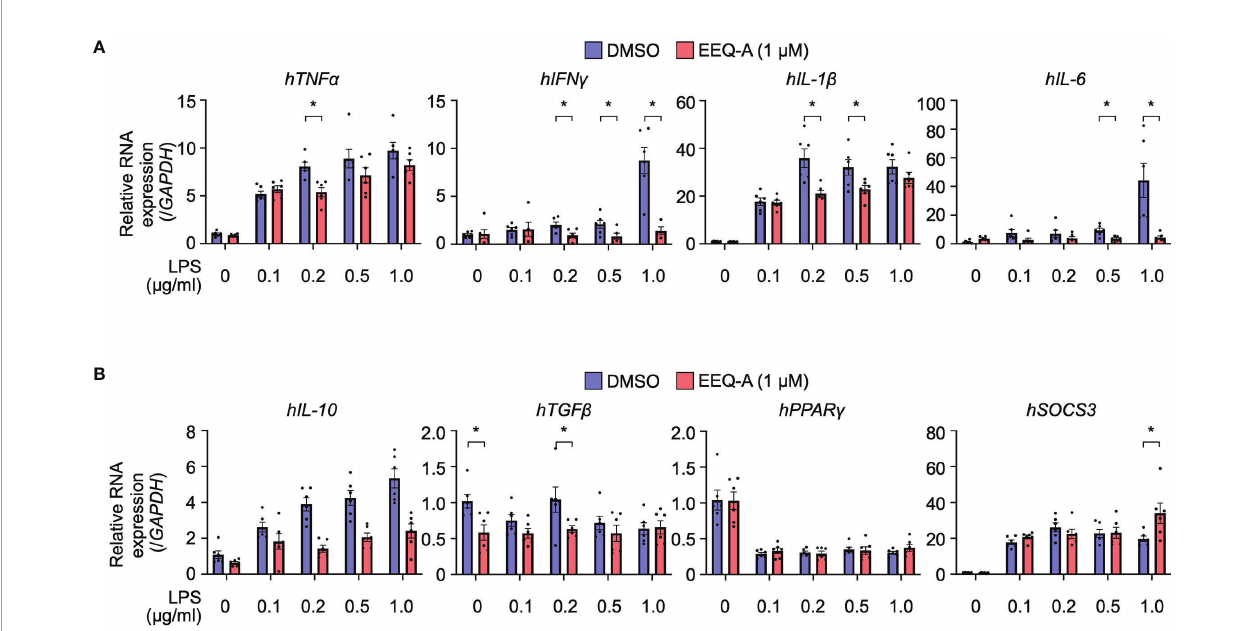
FIGURE 3 | RNA expression of proin fl ammatory (A) and anti-in fl ammatory (B) cytokines in THP-1 cells, the in fl ammation model. The cells were harvested 3 hours after LPS administration. P-values *0.0001 to 0.05. All experiments were